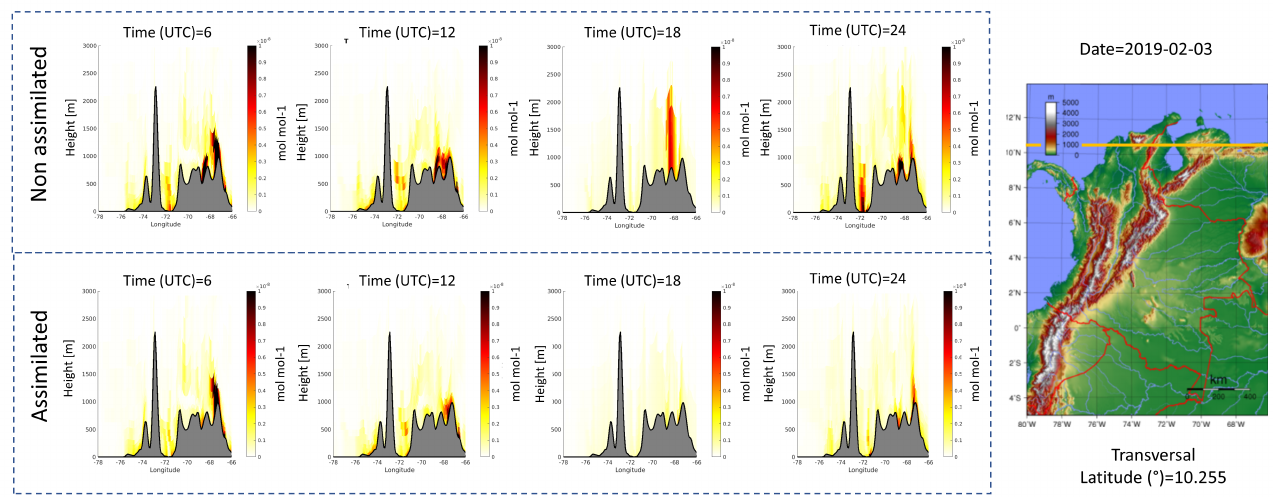
Figure 9. Transverse cut profiles for NO 2 concentration over latitude = 10.255° for four different time points during the assimilation window day (3 February 2019). The adjustment in emission parameters affected the simulated NO 2 column estimates at various heights, as well as the associated plume. Shaded grey denotes topography.